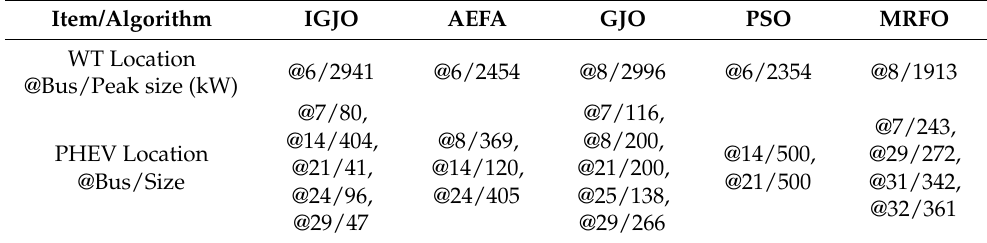
Figure 5. The convergence process of different algorithms in the allocation and scheduling of WT and PHEVs in the distribution network. Table 3. The optimal solution using different algorithms.